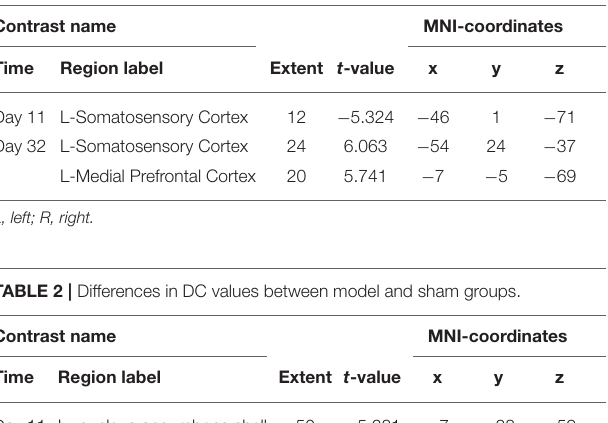
FIGURE 4 | 11 after CCI surgery and significantly higher ALFF values in both the left somatosensory cortex and mPFC on day 32 after CCI surgery as compared to sham group rats; (B) ALFF values in the left somatosensory cortex (10 days after CCI surgery) positively correlated with MWT values (7 days after CCI surgery); (C–H) ALFF values in the left somatosensory cortex and mPFC (32 days after CCI surgery) negatively correlated with MWT (28 days after CCI surgery), distance traveled and time spent in the central zone of OFT (29 days after CCI surgery); (I,J) The ALFF values in the left somatosensory cortex and mPFC (32 days after CCI surgery) was positively correlated with immobility time on FST (31 days after CCI surgery).